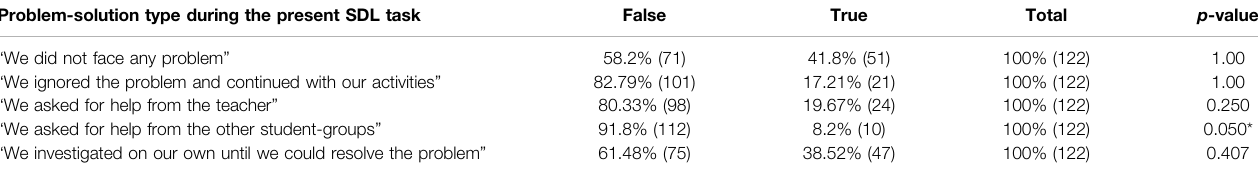
TABLE 2 | Participants ’ reports on their problem-solution strategies. Problem-solution type during the present SDL